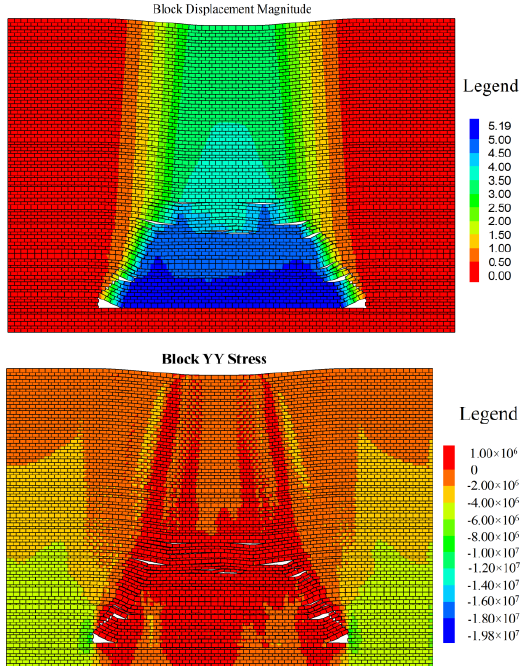
Figure 11. Nephogram ofstress and displacement in the y direction.